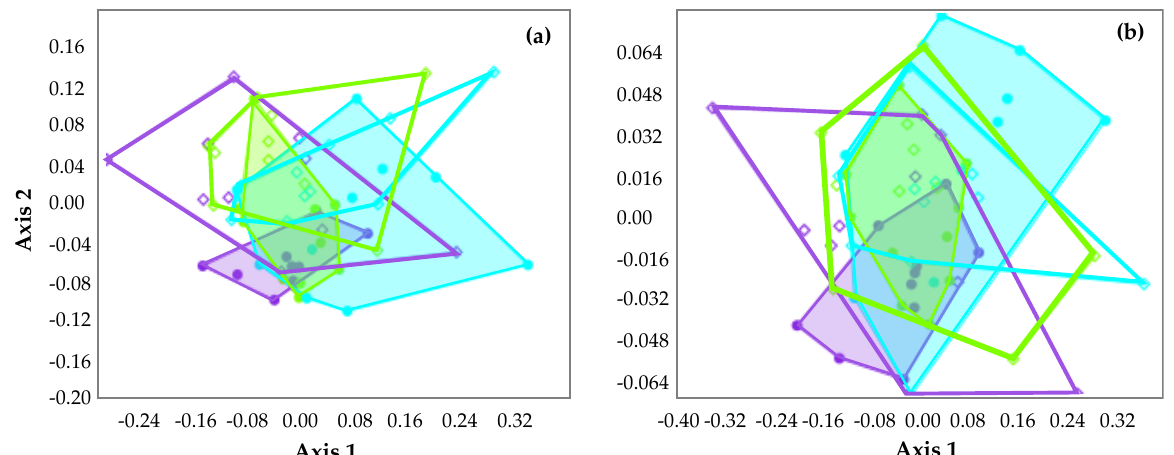
Figure 4. Non-metric multidimensional scaling (NMDS) showing the Bray – Curtis distances between benthic assemblages collected at the three sampling sites (IF1 = light blue; MF1 = purple; MF2 = green) in the different periods (I-warm = filled dots and convex hulls; NI-cold = empty diamonds and convex hulls), taking into account taxonomical composition ( a ) and composition in functional feeding groups ( b ). Stress values: 0.17 ( a ) and 0.07 ( b ). Table 2. Result of the SIMPER analysis of the taxonomical composition of macroinvertebrate assemblages collected at each site in the two sampling periods (I-warm = May-October; NI-cold = November-April). Only the taxa mainly contributing to the differentiation (i.e., those whose cumulative contribution amounts to > 95% of the total differentiation) are shown. AD = overall average dissimilarity, MA = mean abundance (individuals 0.5 m − 2 ), C (%) = percentage of contribution to the